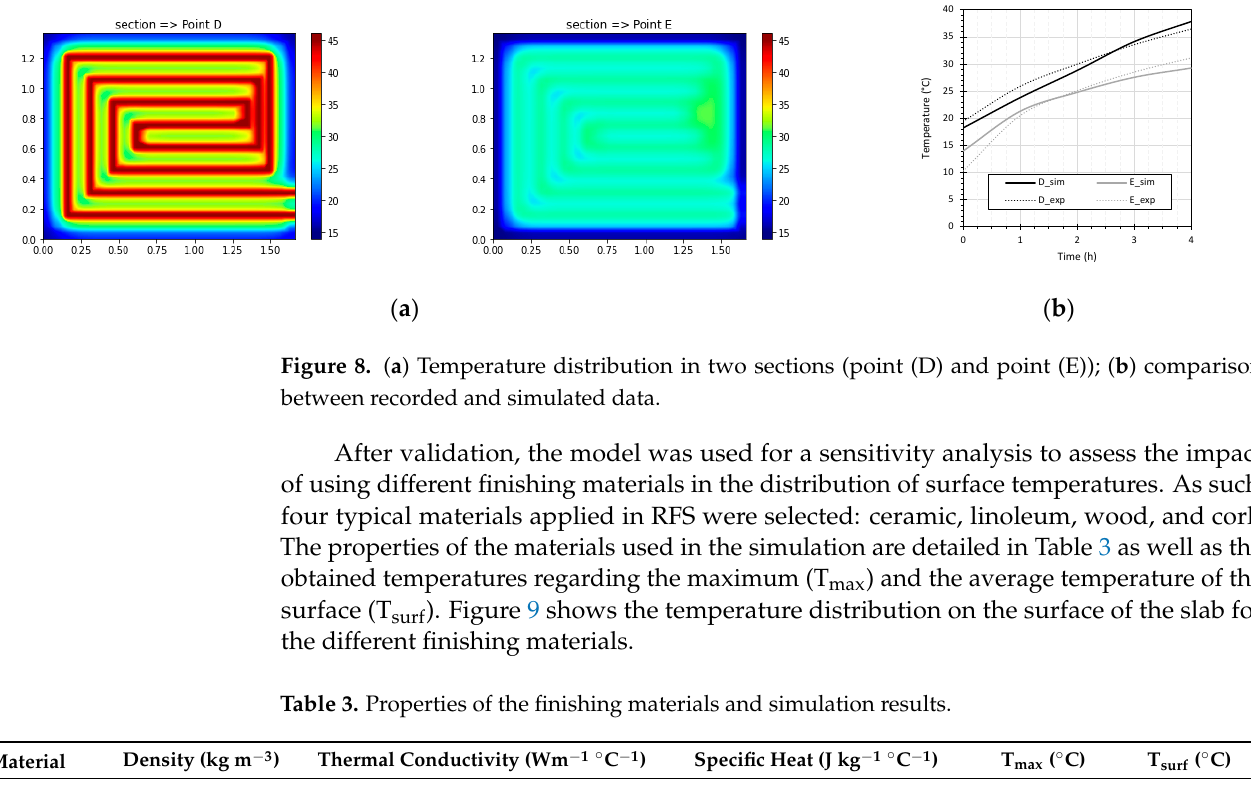
Table 2. Properties of the materials in the FE model.